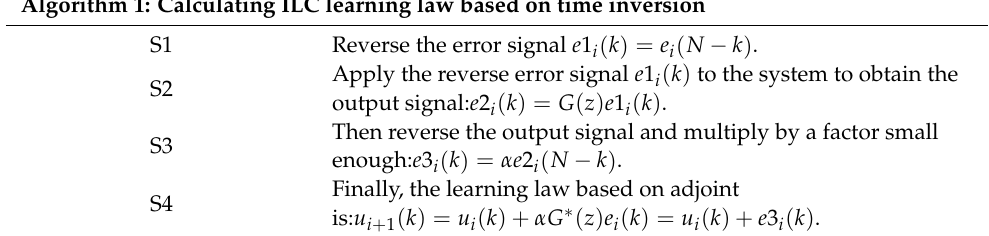
Algorithm 1: Calculating ILC learning law based on time inversion